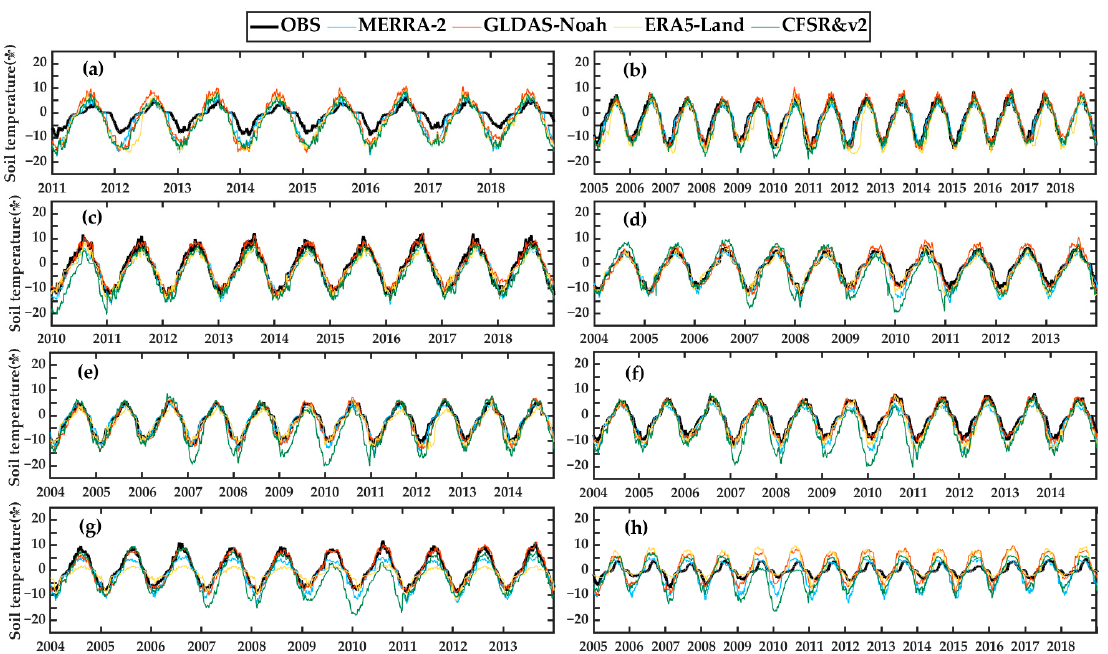
Figure 3. Comparison of the daily average of reanalysis soil temperature to in situ observed at a depth of 50 cm. OBS: observations data, ( a ) QT09, ( b ) Ch06, ( c ) QT08, ( d ) QT01, ( e ) QT03, ( f ) Ch01, ( g ) QT05, ( h ) Ch04.